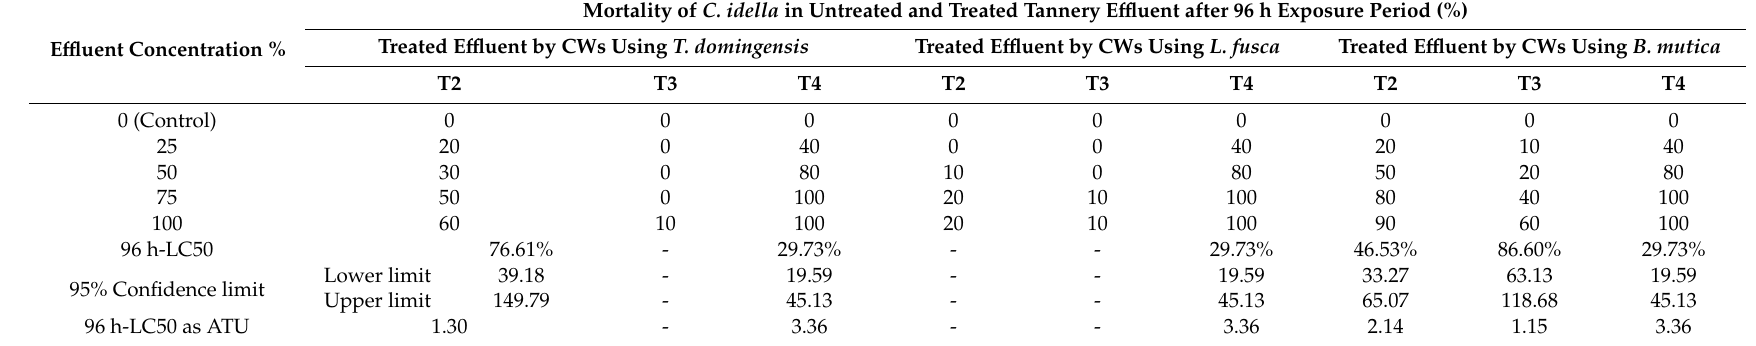
Table 2. Mortality of Ctenopharyngodon idella exposed to di ff erent concentrations of both untreated and treated tannery e ffl